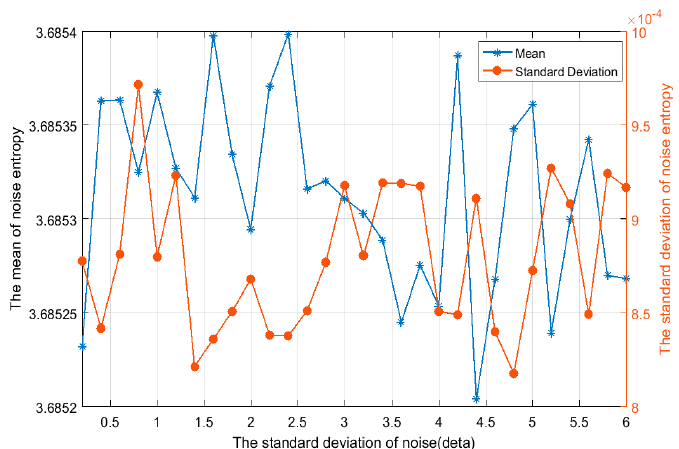
Figure 8. The relationship between distribution characteristics and standard deviation of the noise